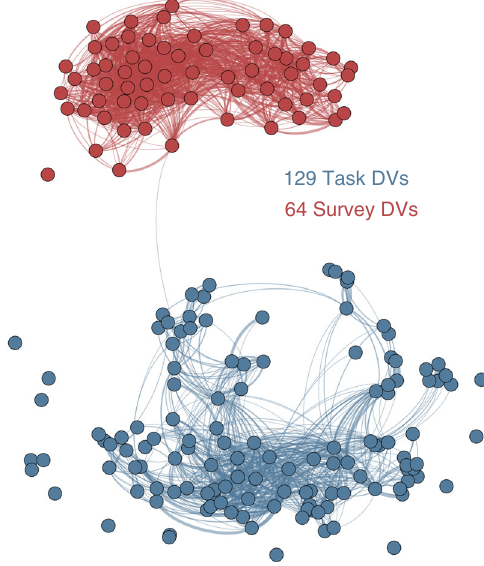
Fig. 2 Relationships of all DVs. Graphical lasso 58 was used to estimate a sparse undirected graph representing the relationships amongst all DVs. Nodes represent the 193 DVs, while edges represent the estimated partial correlation between two DVs. DVs are colored according to measurement category (task DVs: blue) and edges have been thresholded (partial correlation strength > =